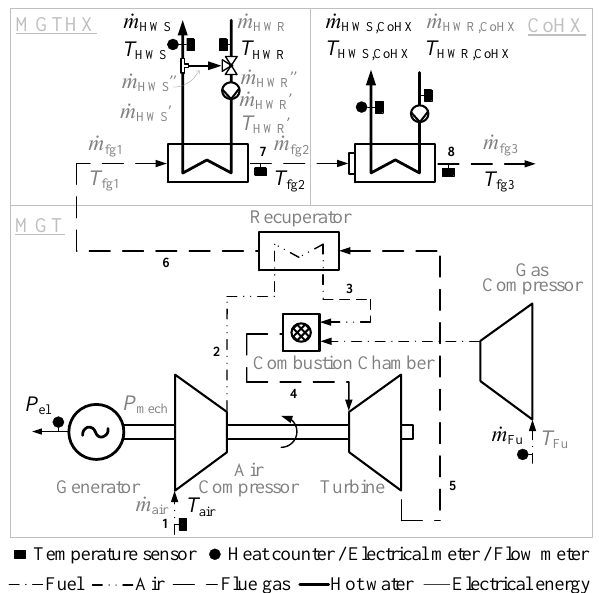
Figure 1. Instrumentation type and measurement points position of the MGT system at the Energy Center. The measured signals are highlighted in black font color. Table 1. Nameplate information of the MGT